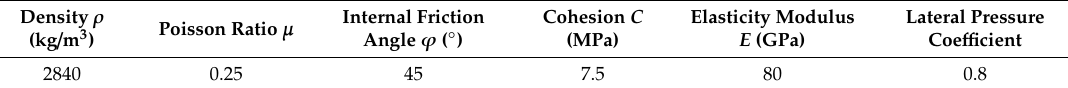
Figure 5. Arrangement of boreholes.